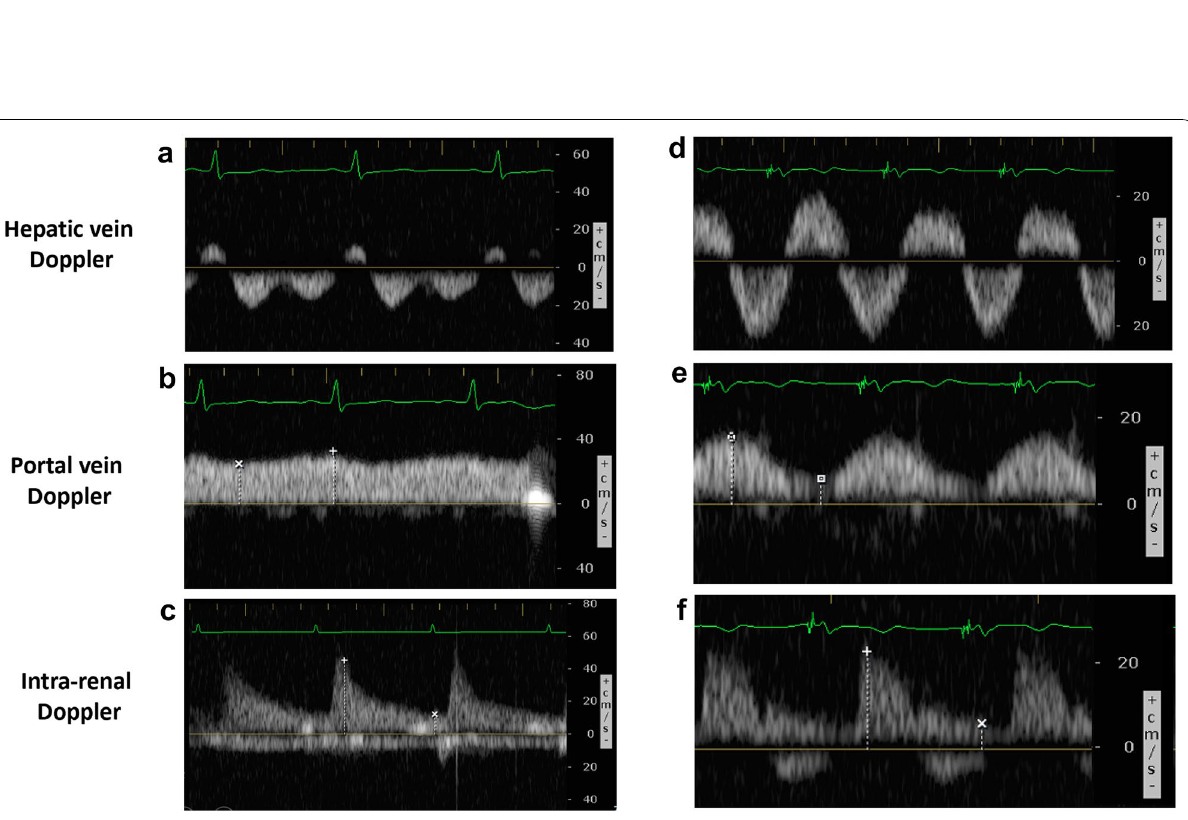
Fig. 5 Example of VExUS C grading system assessment in cardiac surgery. Patient #1: A 55‑year‑old woman undergoing tricuspid valve repair aortic valve replacement and mitral valve replacement known with chronic kidney disease (baseline eGFR ventricular ejection fraction of 40% and a high risk of major complications (EuroSCORE II